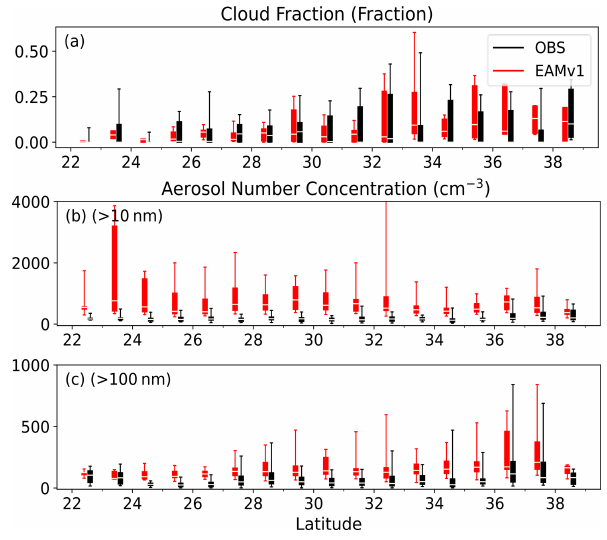
Figure 15. Percentiles of (a) cloud fraction, (b) aerosol number concentration for diameters > 10nm, and (c) aerosol number con- centration for diameters > 100nm for all aircraft measurements be- tween 0 and 3km in CSET binned by 1 ◦ latitude bins. The per- centile box represents the 25th and 75th percentiles, and the bar represents the 5th and 95th percentiles. The observed aerosol num- ber concentrations for diameters > 10 and > 100nm are obtained from CNC and UHSAS,